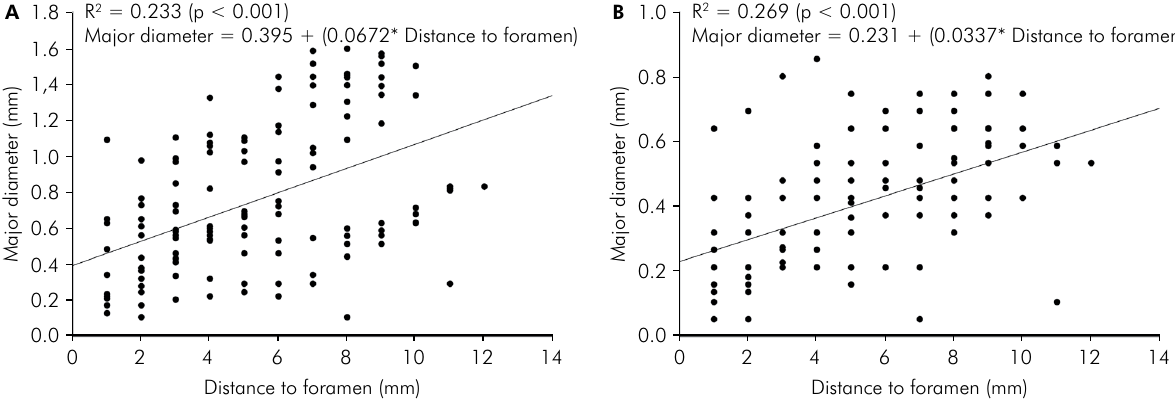
Figure 1. Relationship between major diameter (A) and minor diameter (B) with the distance from the apical foramen.